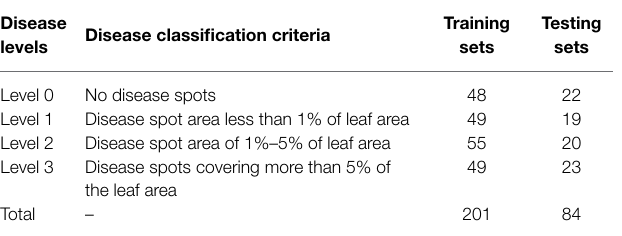
TABLE 1 | Disease classification criteria and sample size statistics. Disease Disease classification criteria levels